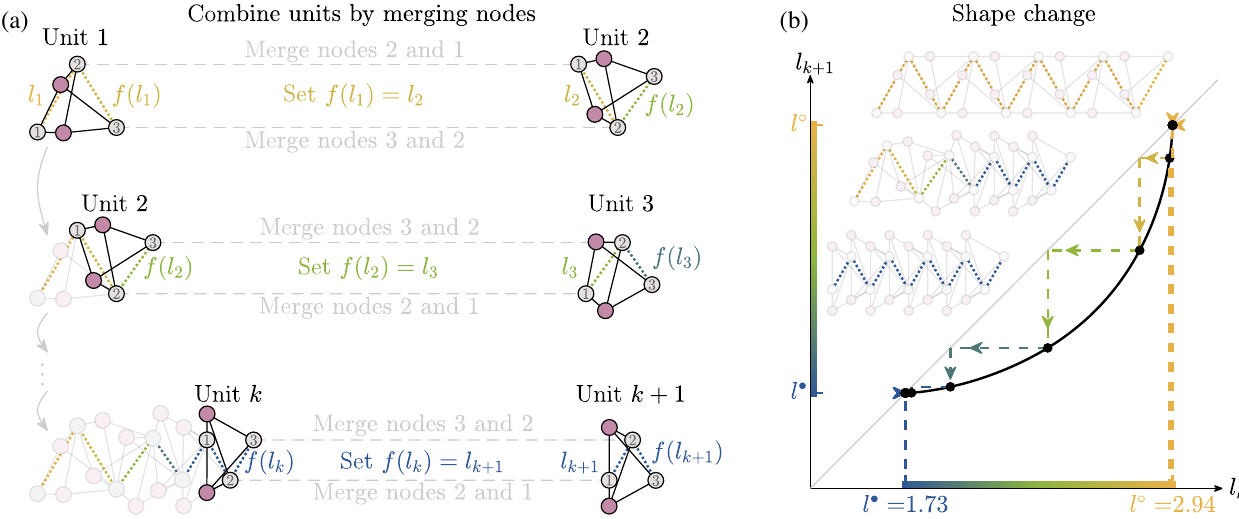
FIG. 8. Representing the combining of designed units as an iterated map. (a) Combining units by merging nodes. A unit k þ 1 is combined with unit k by merging nodes. First, the length l k between nodes 1 and 2 of unit k þ 1 is set equal to length f ð l k Þ between þ 1 nodes 2 and 3 of unit k . Then, node 2 of unit k þ 1 is overlapped and glued together with node 3 of unit k to become a single node, and node 1 of unit k þ 1 is overlapped and glued together with node 2 of unit k . (b) Cobweb plot of the curve l k ¼ f ð l k Þ for the designed þ 1 unit, with three cobweb plots drawn at initial lengths of l 1 ≈ 1 . 73 , 2.93, and 2.94, with a drawing of the network corresponding to each cobweb